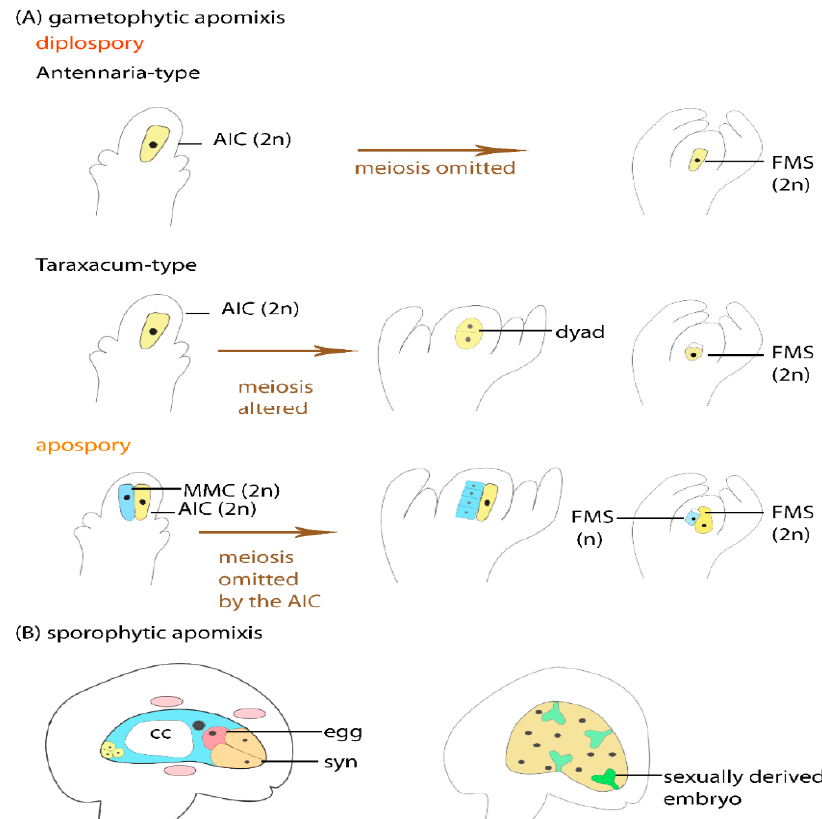
Figure 2. Major types of apomixis. ( A ) Different types of gametophytic apomixis are classified based on the origin and fate of the first cell of the germline lineage. In the Antennaria-type of diplospory the apomictic initial cell (AIC) directly specifies into an unreduced functional megaspore (FMS). In the Taraxacum-type of diplospory meiosis of the AIC is altered to give rise to a dyad of unreduced megaspores of which only one survives as the FMS. During apospory, an additional sporophytic cell in the ovule specifies adjacent to the sexual MMC. This cell omits meiosis to give rise to the FMS. While the sexual germline lineage typically gets repressed by the apomictic germline lineage, also the MMC can undergo meiosis resulting in the formation of two gametophytic lineages, one sexual, one apomictic, in the same ovule. ( B ) During sporophytic apomixis, the sexual gametophyte forms and additional sporophytic cells in the surrounding ovule tissues acquire the competency for embryogenesis (depicted in light red). After fertilization this typically leads to polyembryony, with the sexually derived embryo (dark green) and the somatic embryos (light green) competing for resources.